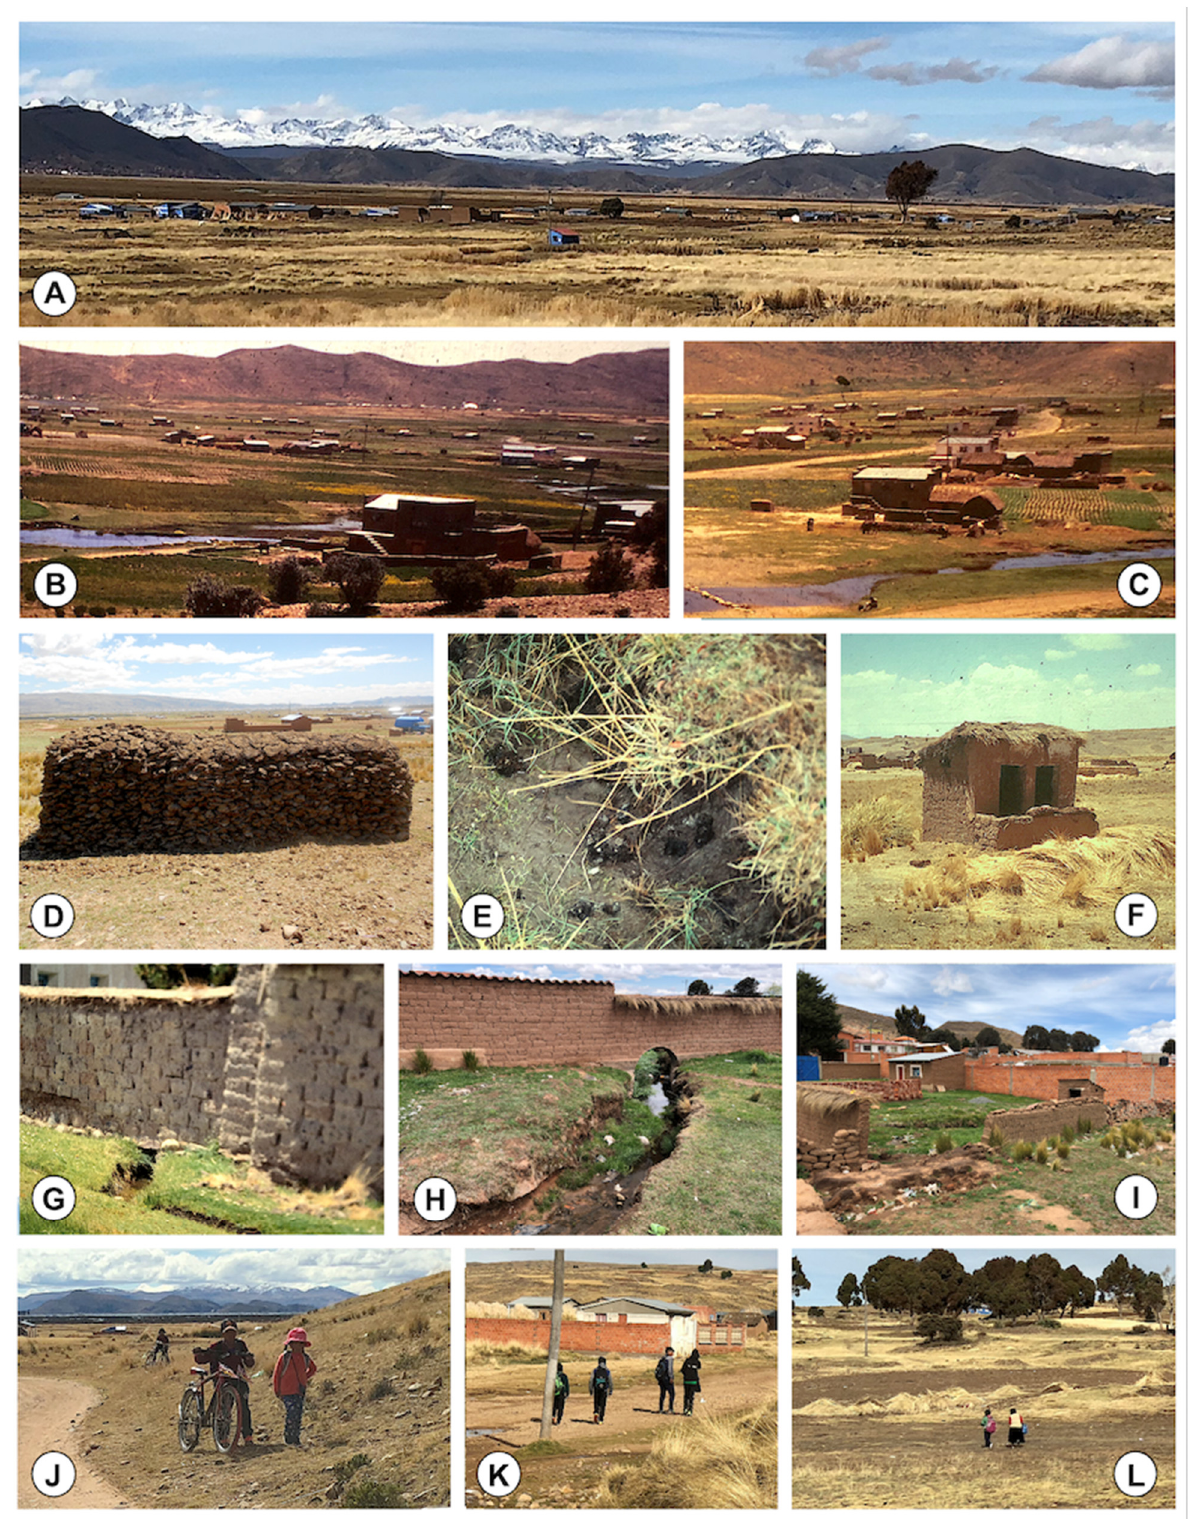
Figure 8. Characteristics of the households: ( A – C ) Aymara communities use to live in dispersed dwellings, with livestock freely running and lymnaeid-inhabited freshwater collections in between and alongside, as in Huacullani ( A ) and Cutusuma ( B , C ); ( D ) heaped dried cattle manure, in Ticuyo; ( E ) Outside defaecation is traditionally practiced in places where freshwater is present; ( F ) Latrines for communities are scarcely found in the open field, as in Chiripujo; ( G – I ) Waste canalization coming from the latrine ( I ), crossing the outdoor household walls, and externally contacting lymnaeid-inhabited freshwater collections ( G , H ) are sometimes found, as in Chirapaca ( G ) and Peñas ( H , I ); ( J – L ) Children daily walk from home to school and back through the field, as in Santa Rosa ( J ) and Huacullani ( K , L ). ( A – C , E – L ) Photographs S. Mas-Coma; ( D ) Photograph R.